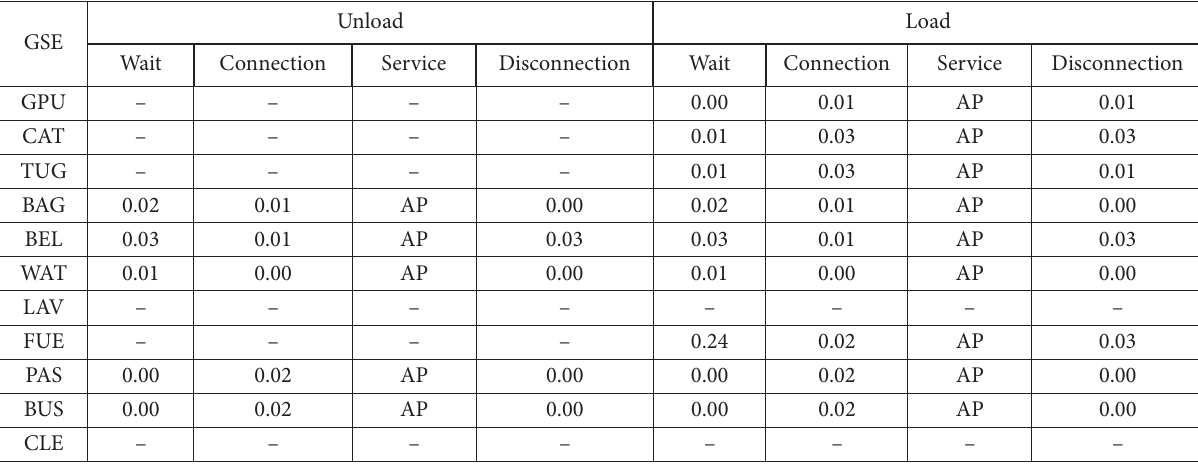
Table A1. Time in hours according to aircraft per GSE (source: authors)